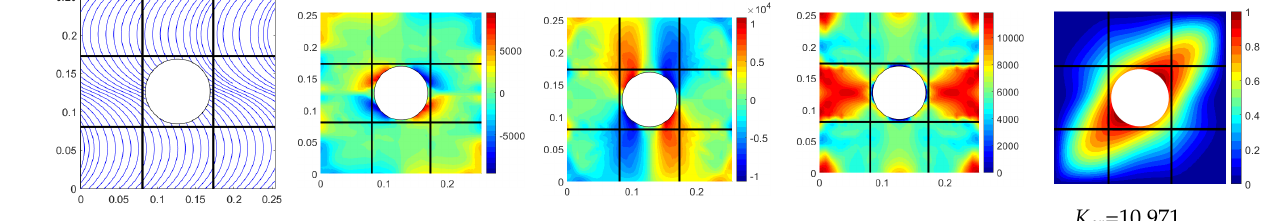
Figure 16. Comparison of optimal fibre paths, stress resultants and buckling modes for different study cases of stiffened plate under in-plane shear displacements. ( a ) QI laminate design; ( b ) SF laminate design; ( c ) LV-X laminate design; ( d ) LV-XY laminate design.